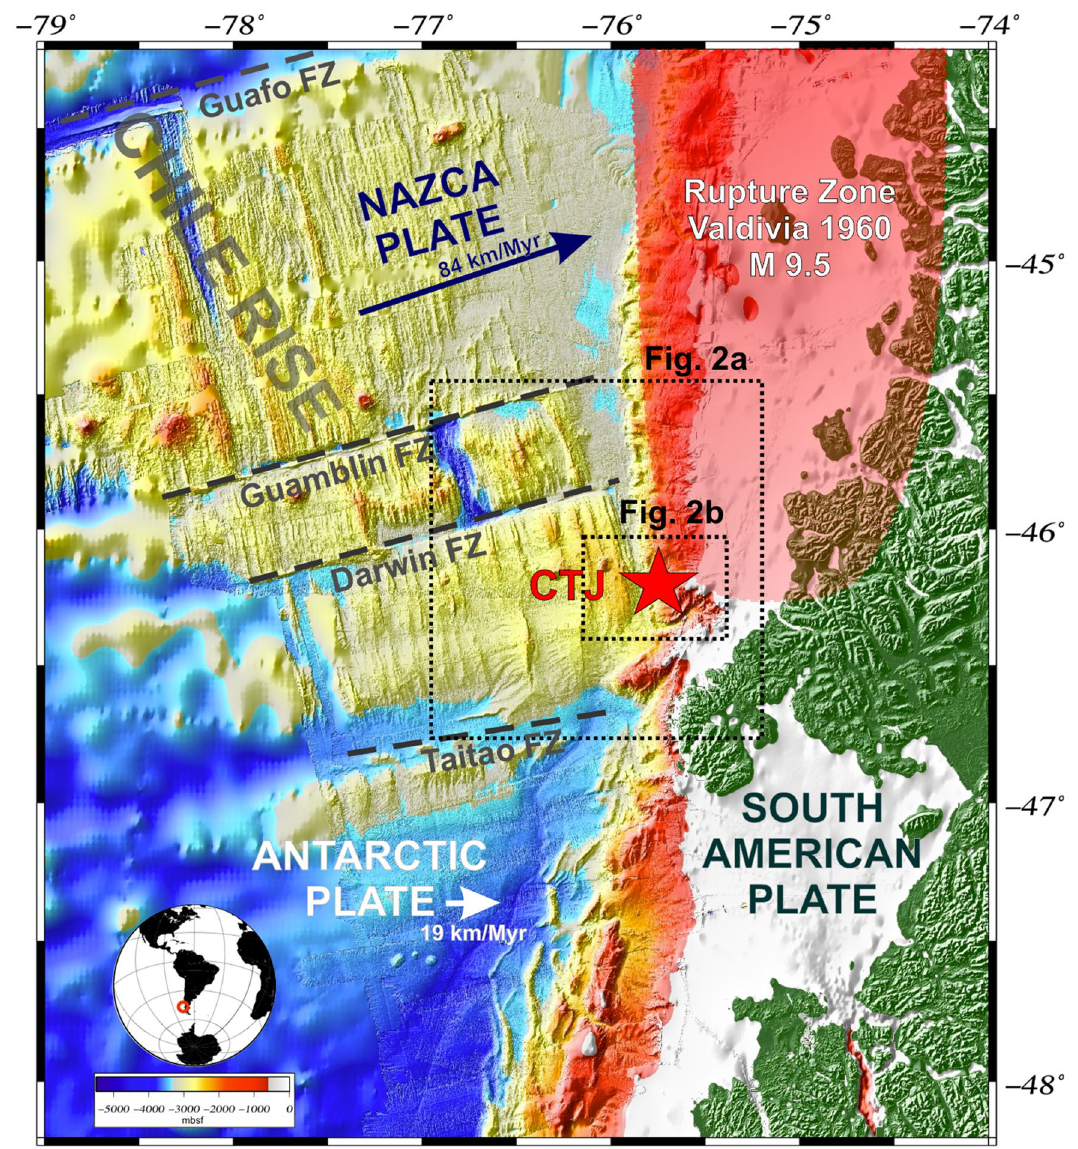
Figure 1. Location map of the study area offshore Taitao Peninsula. The bathymetry is based on GEBCO_2019 Grid (http:// www. gebco. net). Tectonic setting of the Nazca, Antarctic, and South America plates: dashed grey lines show the main Fracture Zones (FZ), red star marks the triple junction of the plates (CTJ), and the red area delimits the rupture zone of the Valdivia’s mega-earthquake. Dashed rectangles correspond to Figs. 2a,b. Figure generated using GMT—v6.2.0 (https:// www. gener ic- mappi ng- tools.